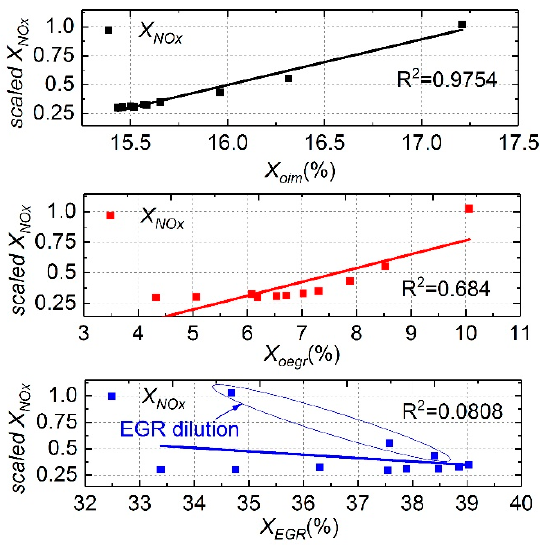
Figure 8. Correlation between NOx concentration and three performance variables.